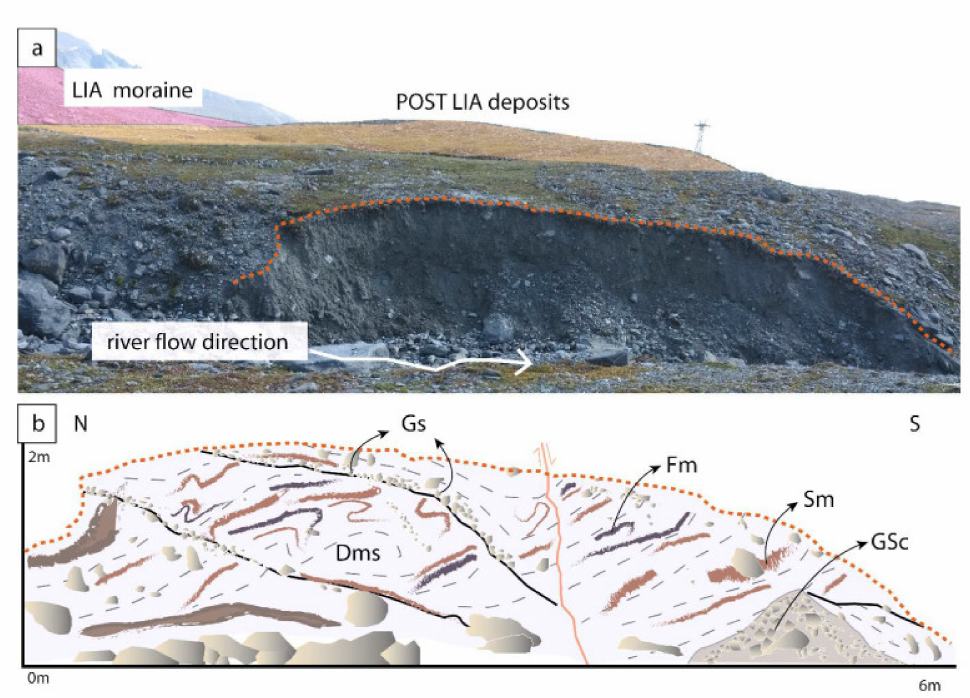
Figure 4. Photograph ( a ) and interpretation ( b ) of a river-cut outcrop through the LIA margin deposits. The interpretation shows that the advancing LIA glacier pushed the sediments. Dms: diamicton completely unsorted, matrix-supported, stratified, Gs: gravel stratified, Fm: fines massive, Sm: sand massive, GSc: gravel, sand, clast-supported [41]. LIA moraine coloured pink in the photograph, post-LIA deposits coloured in orange. See Figure 3 for location of the